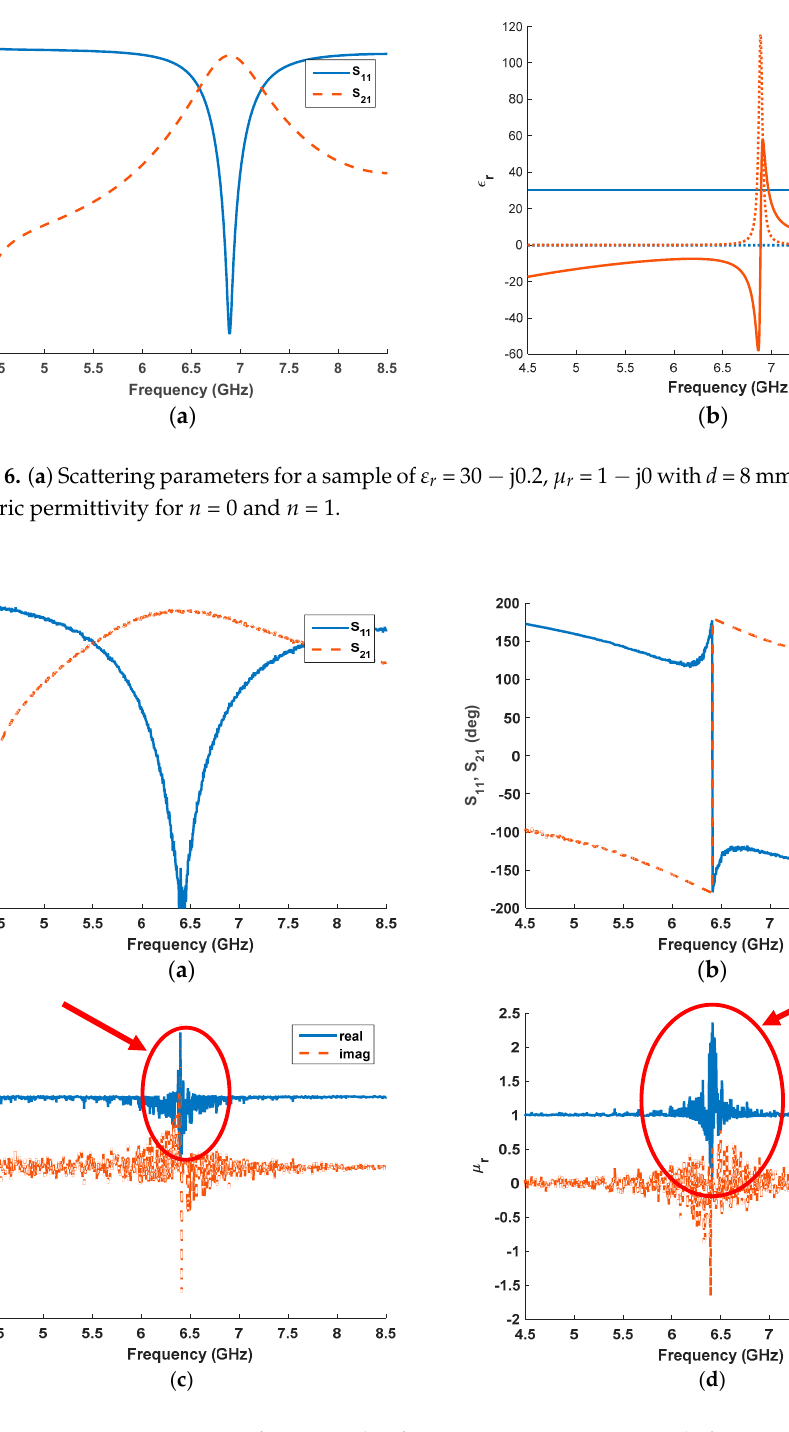
Figure 5. Propagation constant of the medium with NRW with n = 0 ( a ) and with the stepwise method ( b ).